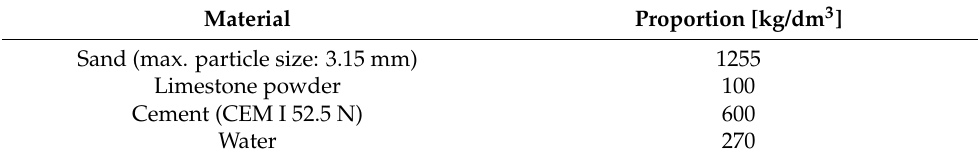
Table 2. Mixture proportion of the sprayable cement